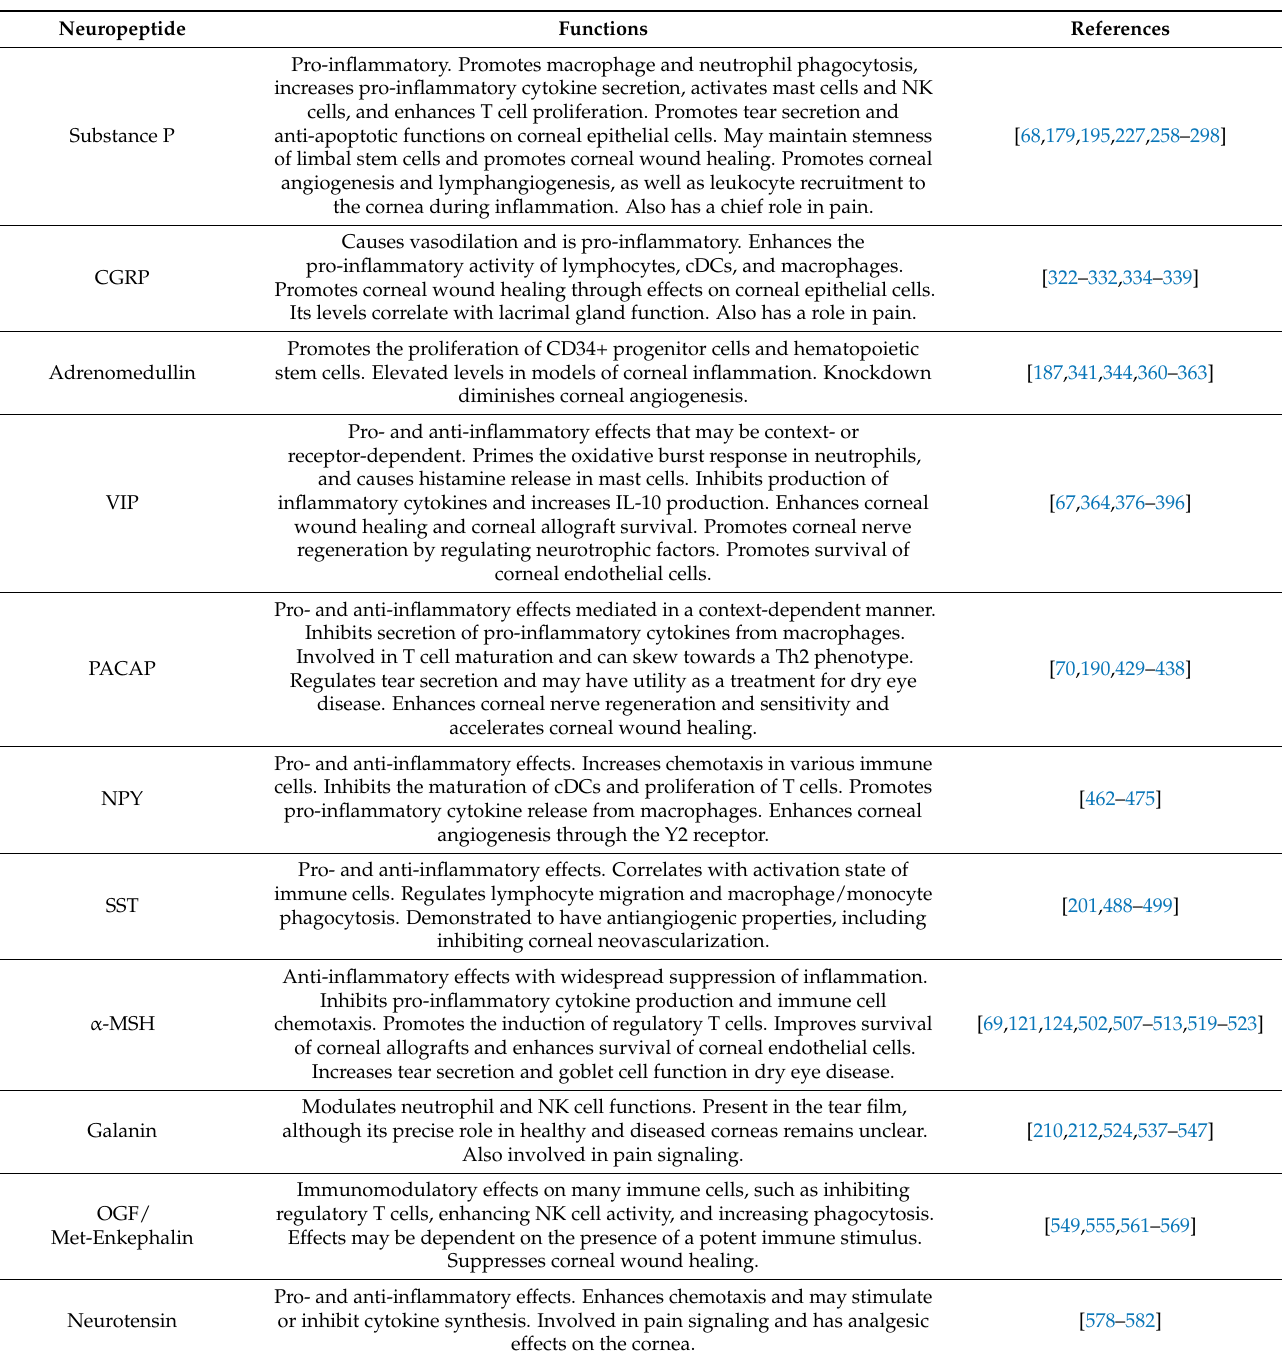
Table 3. Summary of neuropeptide